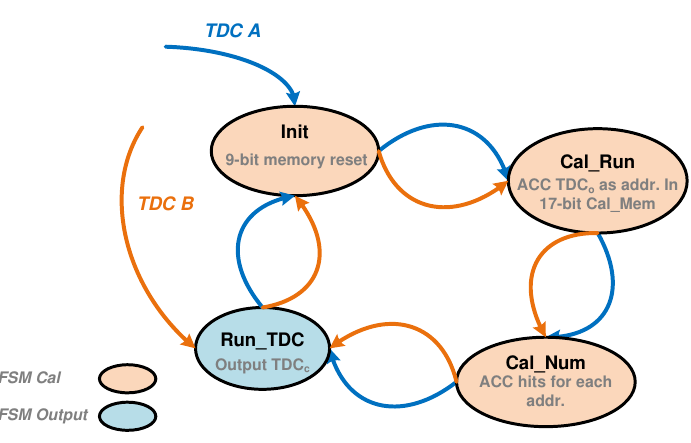
Figure 4. Finite state machine used in DDL-TDC.